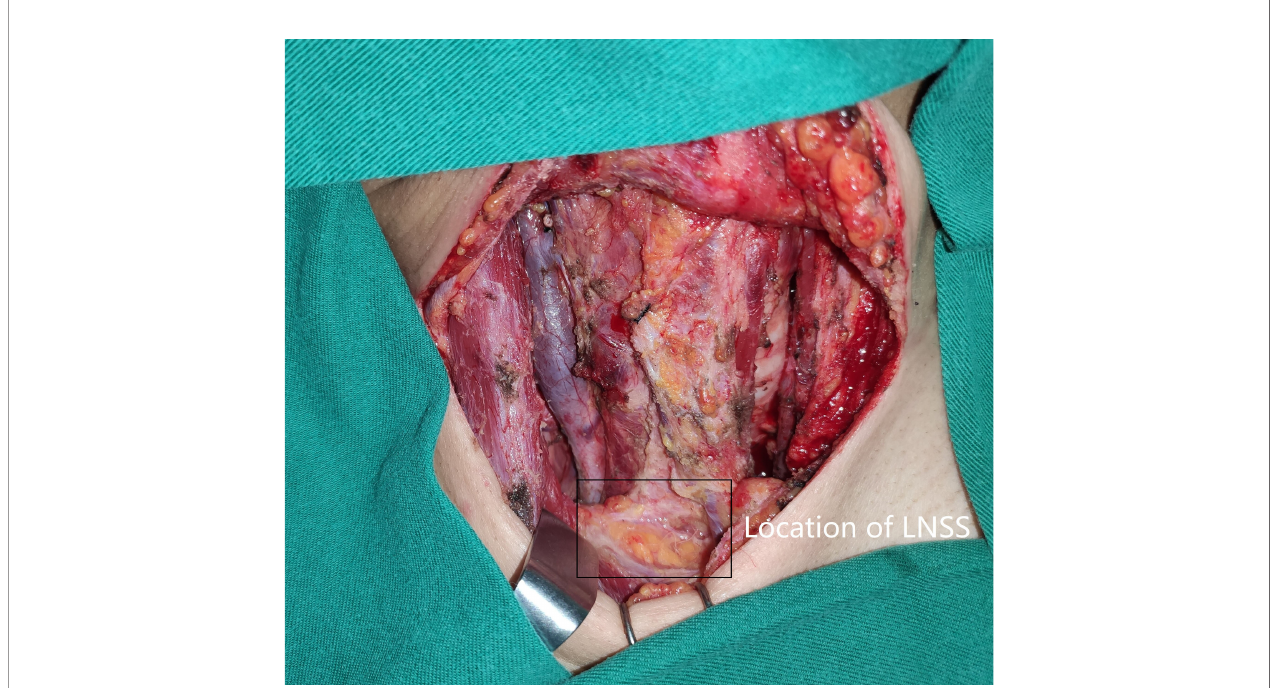
FIGURE 1 | Location (black box) of lymph node between sternocleidomastoid and sternohyoid muscles